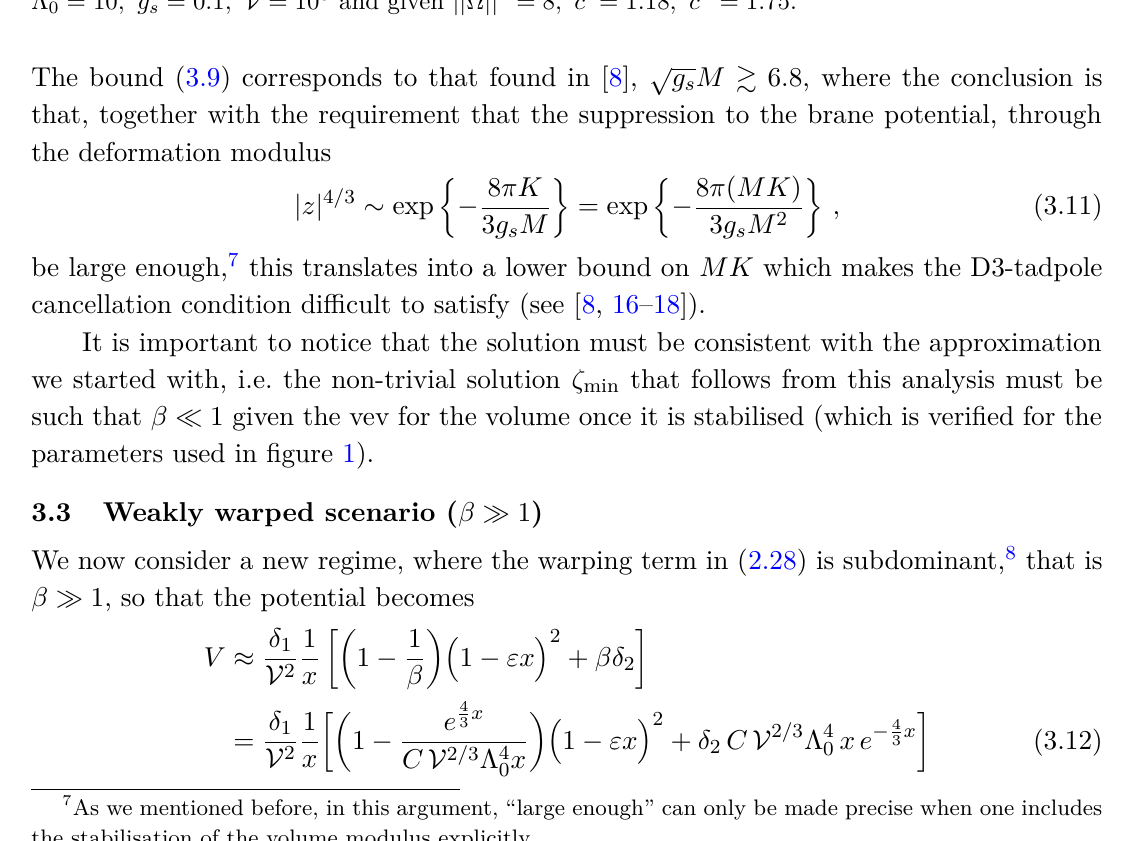
Figure 1. Comparison between two different choices of M ( M = 5 , M = 25 with K = M in both cases) for the potential (3.5) for an example with β (cid:28) 1 , with the choice of parameters Λ 0 = 10 , g s = 0 . 1 , V = 10 3 and given || Ω || 2 = 8 , c 0 = 1 . 18 , c 00 = 1 . 75